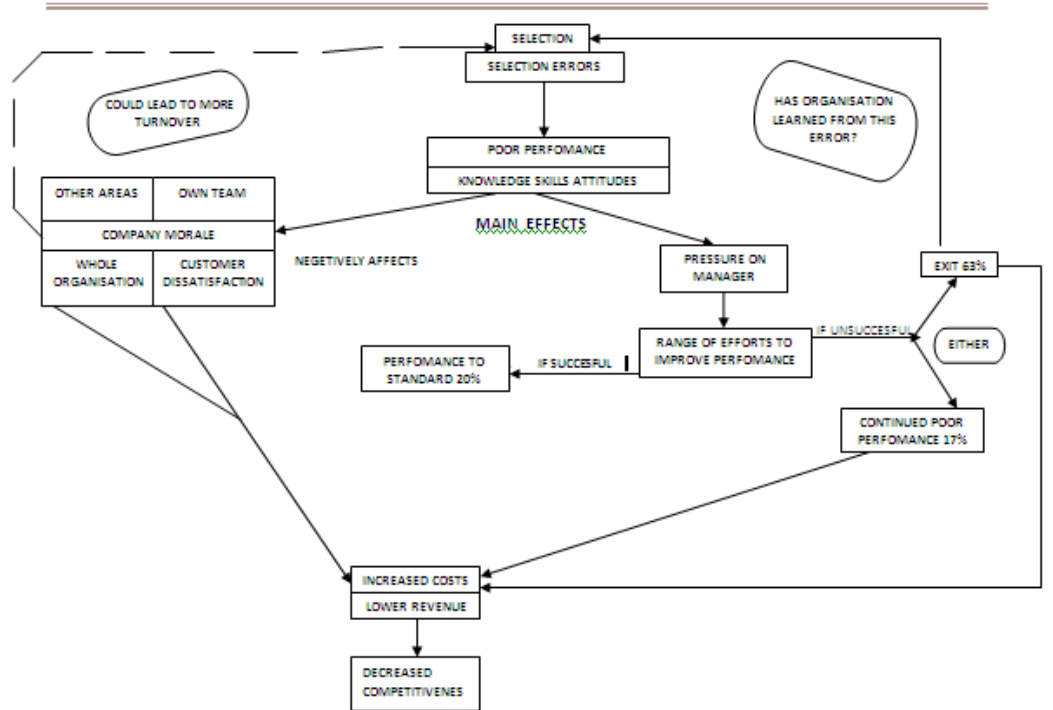
Figure 1: The vicious cycle of selection